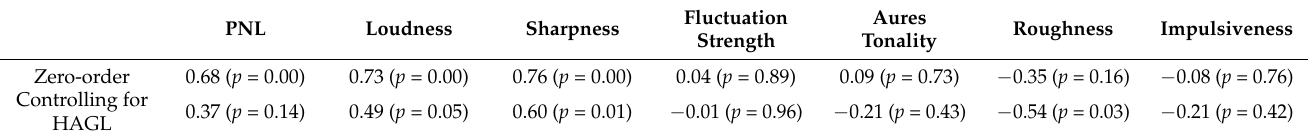
Table 6. Zero-order and partial correlation coefficients (controlling for height above ground level (HAGL)) between PNL and the SQMs (loudness, sharpness, fluctuation strength, Aures tonality, roughness and impulsiveness) and perceived pitch. p -value shown in brackets.